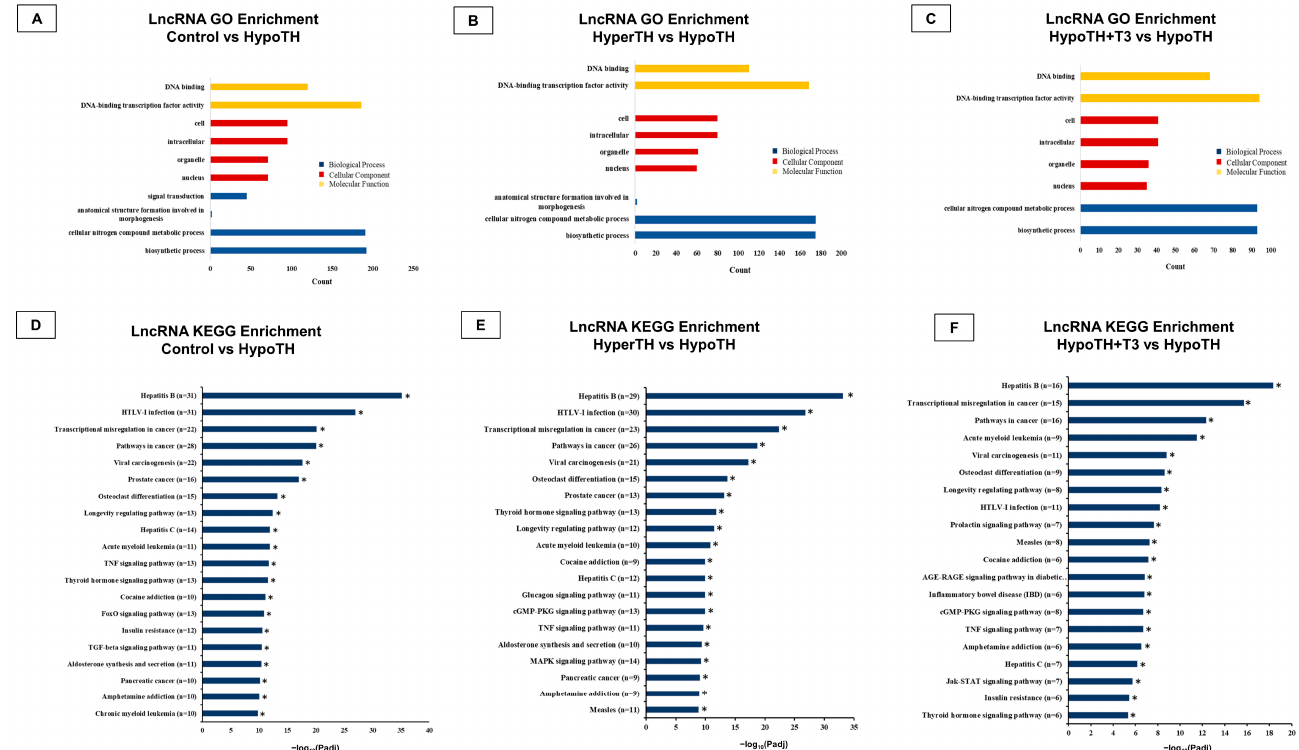
Figure 4. GO and KEGG analyses of lncRNAs revealed significant enrichment: Significantly en- riched ( A – C ) GO terms ( p < 0.05) in ( A ) Control vs. HypoTH, ( B ) HyperTH vs. HypoTH and ( C ) HypoTH + T3 vs. HypoTH groups and ( D – F ) Top 20 KEGG pathways associated with differ- entially expressed genes compared with background in ( D ) Control vs. HypoTH, ( E ) HyperTH vs. HypoTH and ( F ) HypoTH + T3 vs. HypoTH groups. Statistically significant KEGG enrich- ments are marked with asterisks; GO: Gene Ontology; KEGG: Kyoto Encyclopedia of Genes and Genomes; HyperTH: Hyperthyroidism; HypoTH: Hypothyroidism; T3: Triiodothyronine; p -adj— adjusted/corrected; * p <